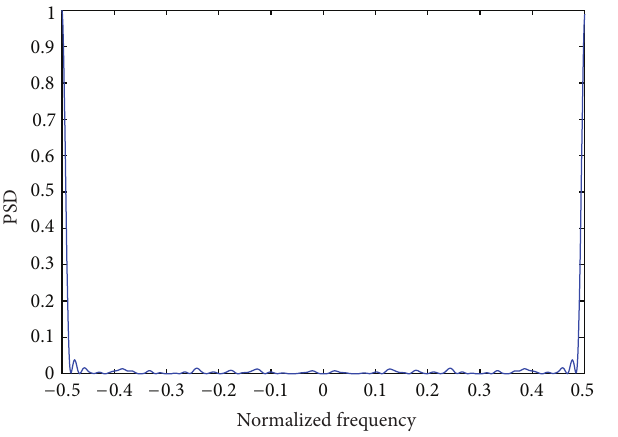
Figure 10: PSD of transmitted waveform.